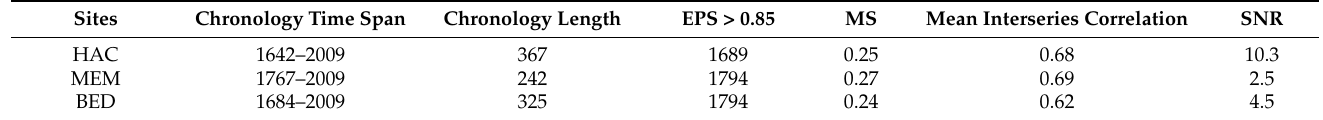
Table 2. Chronology statistics of the sites.